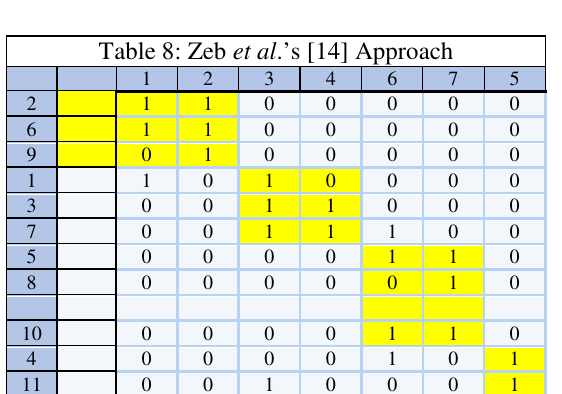
Table 8: Zeb et al .’s [14]